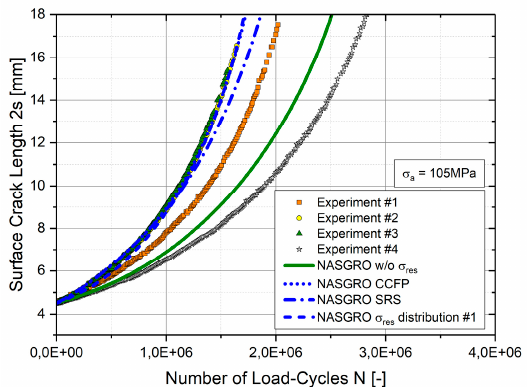
Figure 15. Results of numerical assessments compared to experiments.